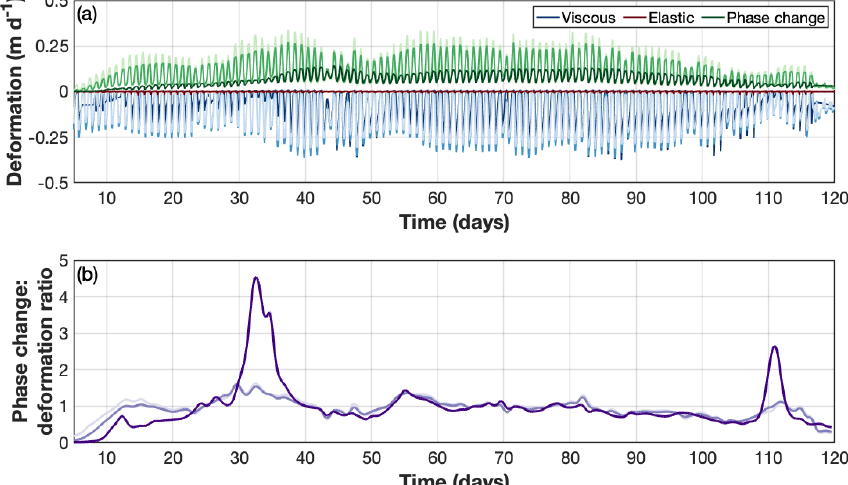
Figure 8. Time series of viscous, elastic, and phase change components of moulin evolution and their relative importance in determining moulin geometry. (a) Time-varying viscous (blues), elastic (reds), and phase change (melting, greens) components of moulin geometry. (b) The daily ratio of the total amount of phase change (melting above and below the water line) to total deformation (elastic plus viscous; shades of purple). Values above 1 indicate that melting dominates; values below 1 indicate that deformation dominates. Data are smoothed over 24h. For both panels, light colors are for Basin 1 ( H i = 553m), medium colors for Basin 2 ( H i = 741m), and dark colors for Basin 3 ( H i = 1315m). Note x axes start on day 5.